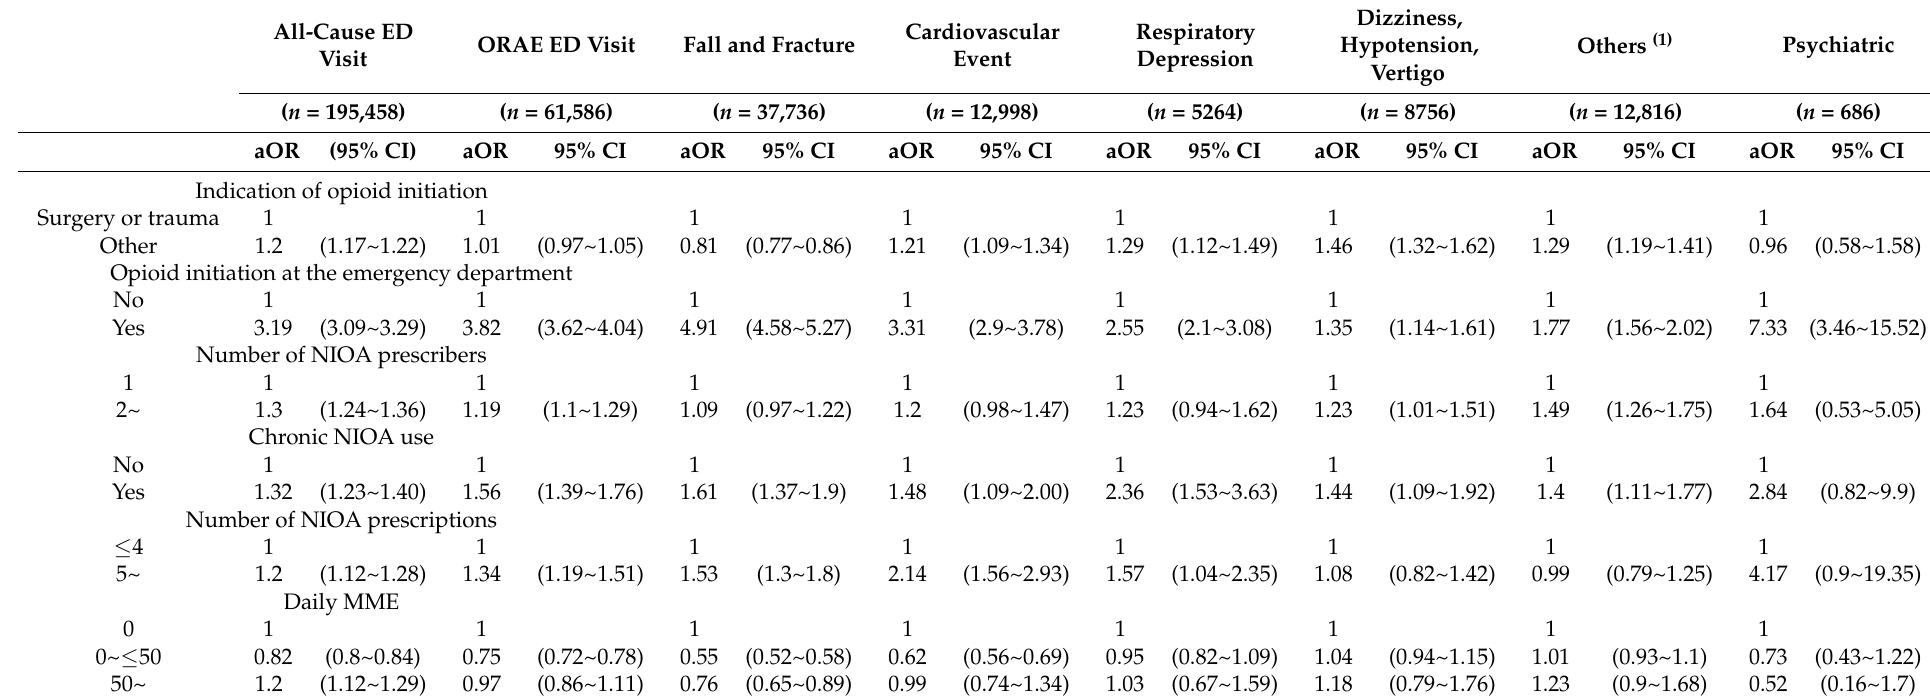
Table 3. Association between the patterns of NIOA use and ED visits after NIOA